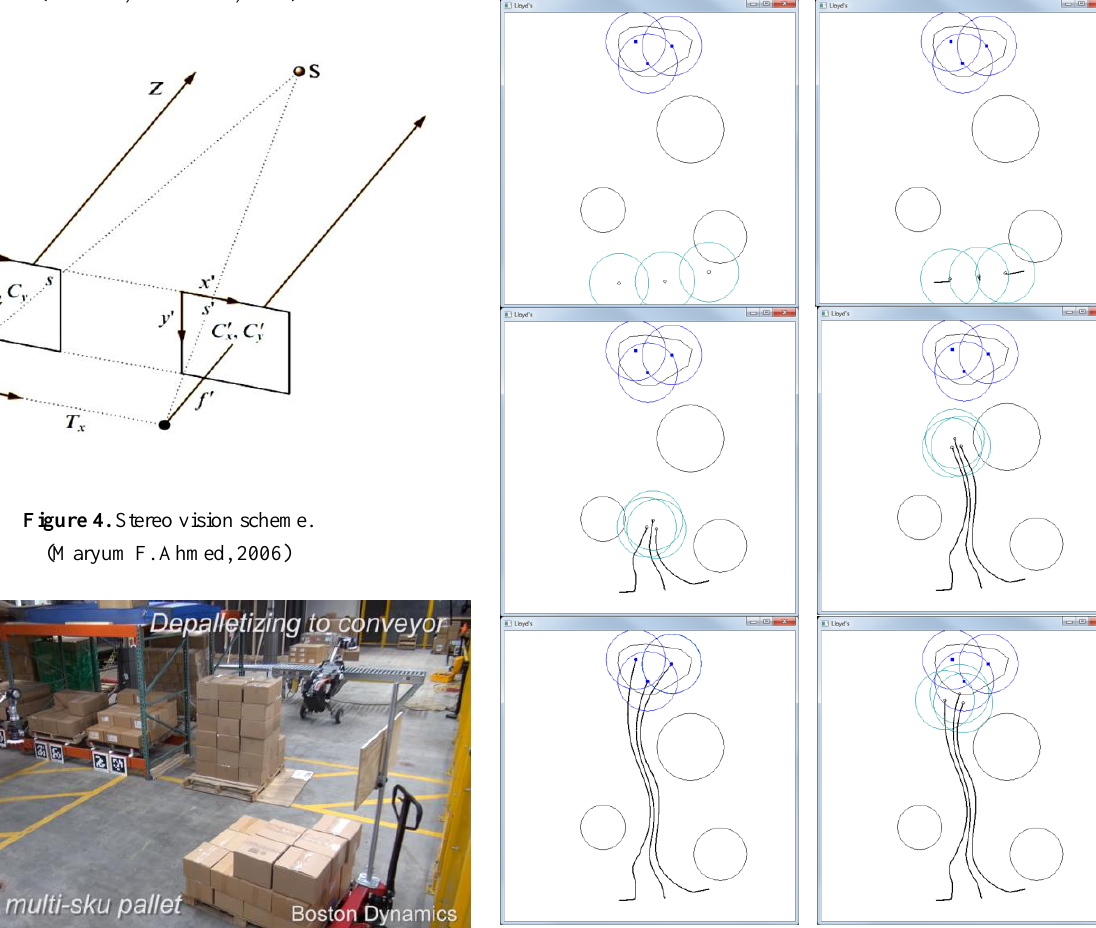
Figure 7. Computer modeling of trajectory planning of mobile robots' group (Gradetsky et al.,